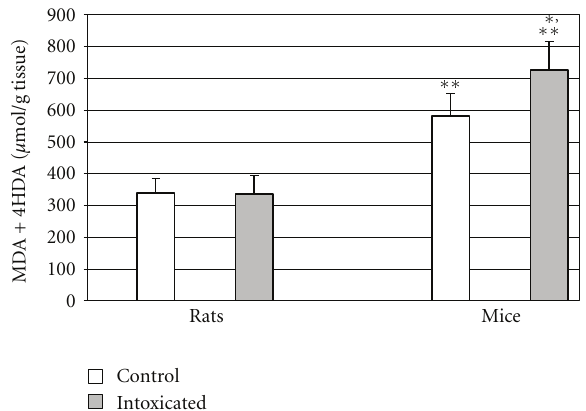
Figure 1: Concentration of lipid peroxidation markers in testicular homogenates of mice and rats. ∗ P < 0 . 05 in comparison to the control, ∗∗ P < 0 . 001 in comparison to both groups of rats.